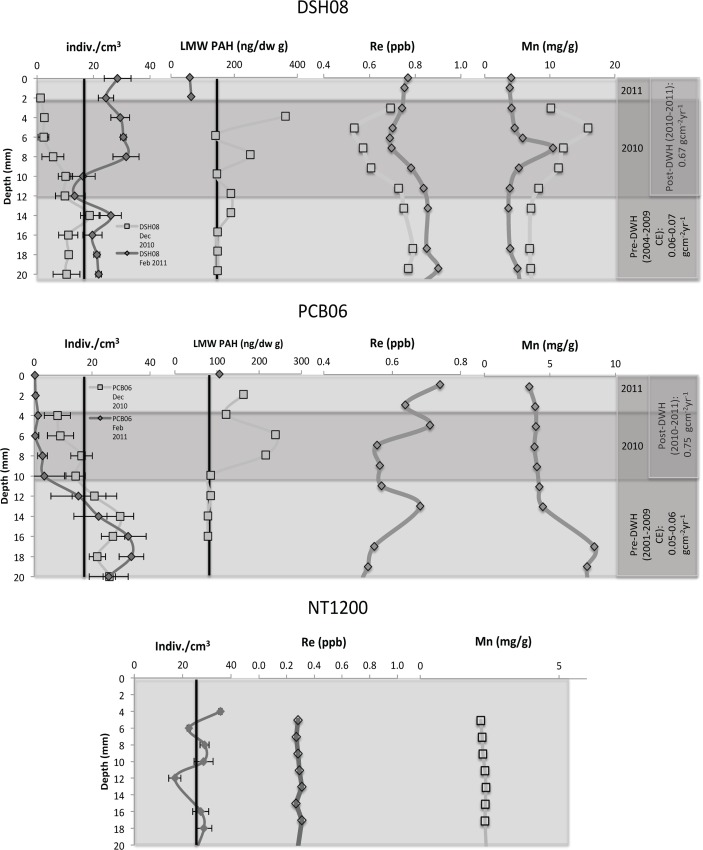
Total benthic foraminiferal density (indiv./cm3), low molecular weight polycyclic aromatic hydrocarbon concentrations (LMW PAH, ng/g dw)[29], and redox sensitive metal (Re, Mn)[28] records stacked using short-lived radioisotope geochronology.Pre-DWH and post-DWH periods are denoted with their respective mass accumulation rates in the gray-shaded areas and the down-core means for benthic foraminiferal density and LMW PAH are represented by black lines.